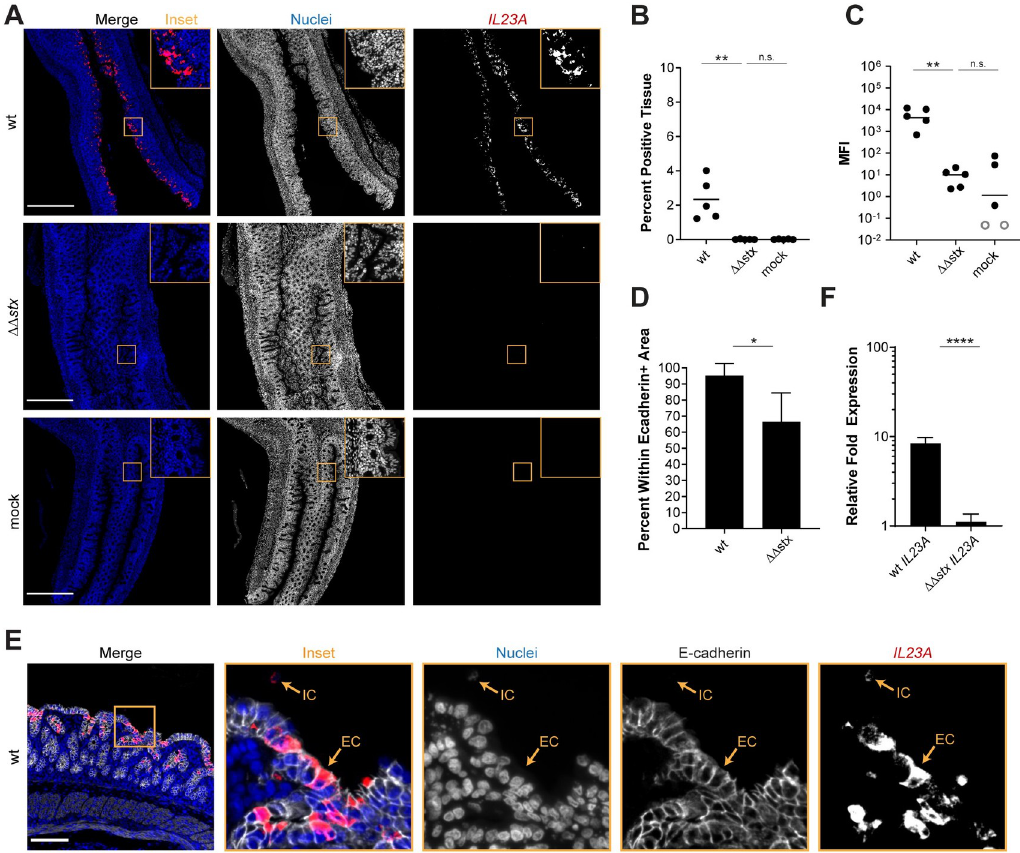
Fig 5. Expression of IL23A in epithelial cells is much greater in animals infected with WT vs ΔΔ stx EHEC. (A) Micrographs of colon sections from rabbits inoculated with WT EHEC, ΔΔ stx EHEC, or PBS (mock) stained with a probe to rabbit IL23A mRNA (red) and DAPI (blue). Scale bar is 500 μ M. (B) Percentage of tissue section with IL23A signal from individual colons. Distributions compared using Mann-Whitney U test, p < 0.01 ( �� ), n.s. indicates not significant. (C) Mean fluorescent intensity (MFI) from individual colons plotted with mean. Distributions compared using Mann-Whitney U test, p < 0.01 ( �� ), n.s. indicates not significant. (D) Percent IL23A signal within E-cadherin positive cells. Distributions compared using the Mann- Whitney U test, p < 0.05 ( � ). (E) Sections stained with a probe to rabbit IL23A mRNA (red), DAPI (blue), and anti-E-cadherin antibody (white). Scale bar is 500 μ M. Example immune cell (IC) and epithelial cell (EC) is indicated. (F) Normalized expression of IL23A in HT29 cells infected with WT EHEC, ΔΔ stx EHEC, or PBS. Expression levels compared with a Students two-tailed t- test, p < 0.001 ( ��� ), n.s. indicates not